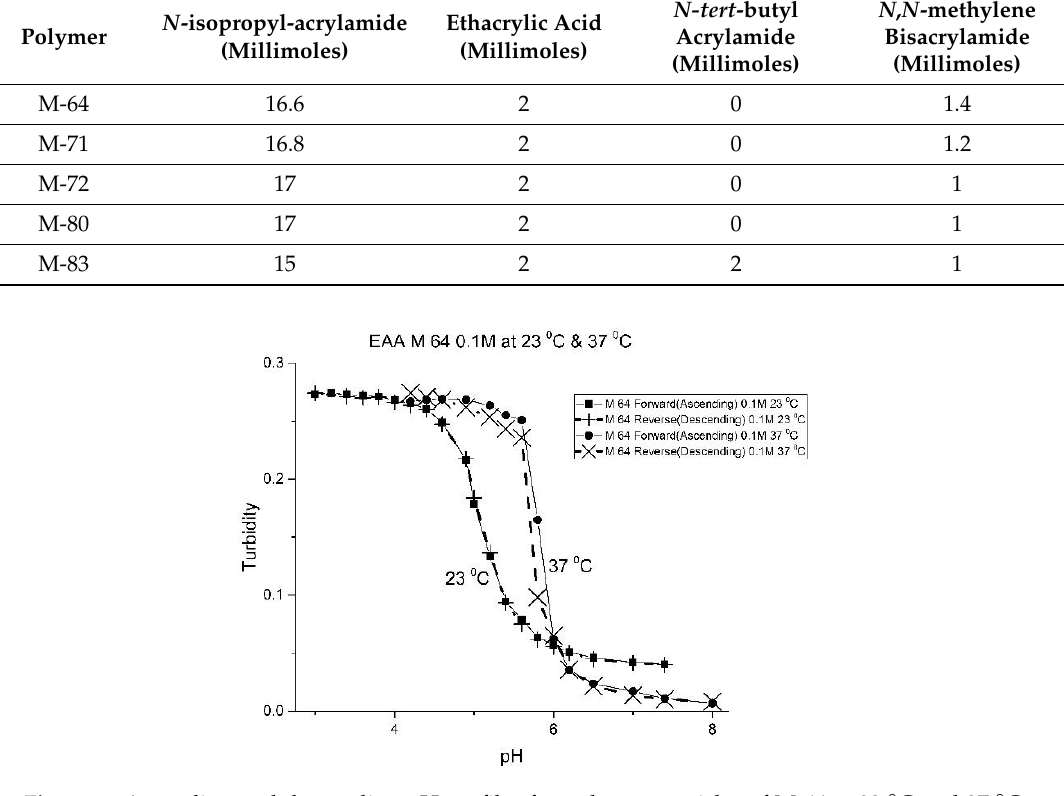
Figure 7. Ascending and descending pH profiles for polymer particles of M-64 at 23 ◦ C and 37 ◦ C. Solid line = ascending pH profile. Dashed line = descending pH profile.